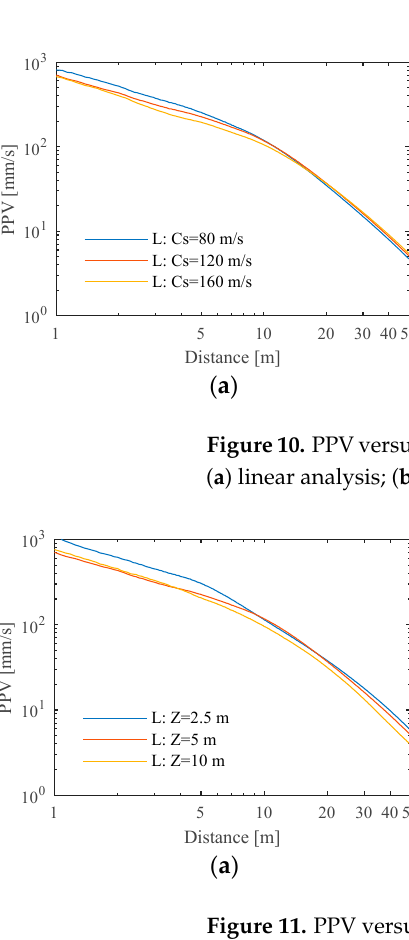
( b ) Figure 12. The norm of the particle velocity in a homogeneous half space at t = 40 ms (left) and t = 125 ms (right) due to impact pile driving for pile embedment depths of ( a ) 2.5 m; ( b ) 10 m (units: 10 3 mm/s).